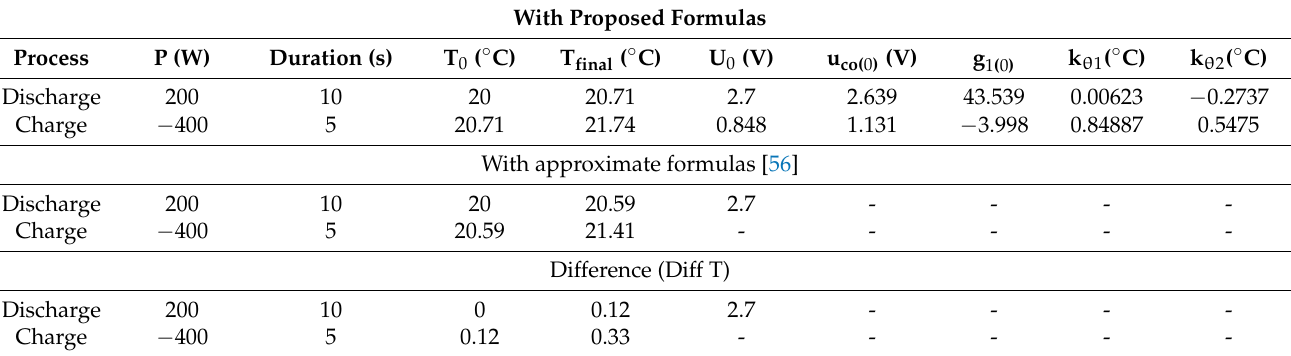
Figure 5. Top chart: Temperature of the cell obtained by using Equations (28)–(34) and the approximate equations given in [56] for discharge and charge at low or moderate power. Bottom chart: Temperature difference between both solutions. Table 3. Charge and discharge parameters at a high power.